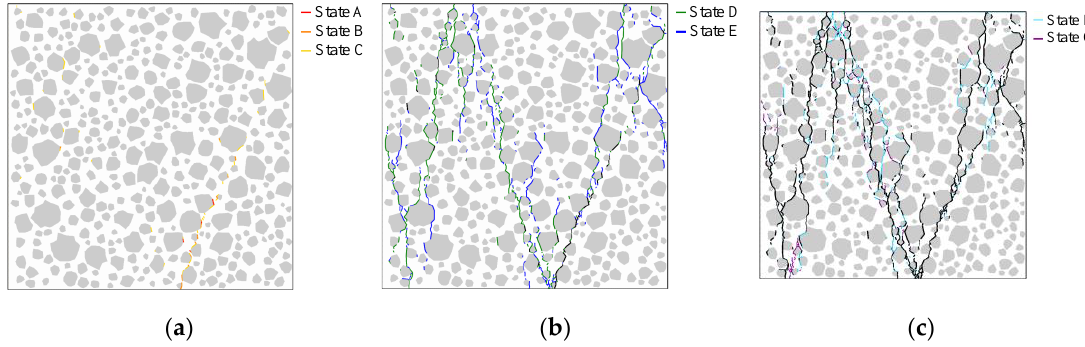
Figure 13. Global stress-strain curve of a specimen under compression.